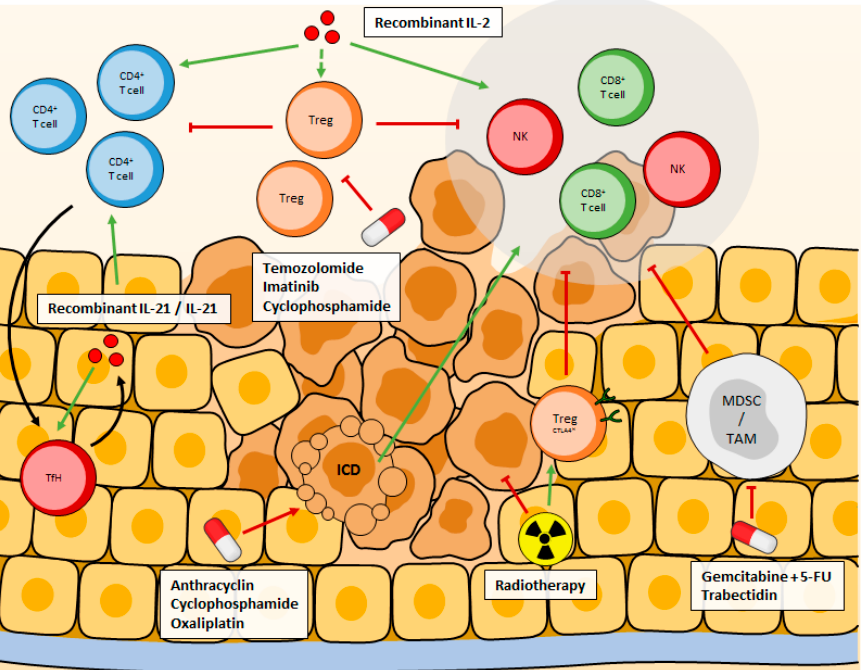
Figure 2. Recombinant IL-2 is designed to preferentially bind to IL2R α or IL2R βγ to avoid Tregs expansion, while stimulating CD4 + , CD8 + , and NK cells. Recombinant IL-21 also stimulates CD4 + , CD8 + , and NK cells as well as TFh cells, creating an auto-amplification loop. Some treatments inhibit Treg cells, MDSCs or TAM, to remove the immunosuppression they exert, while others indirectly promote anti-tumor immune response through immunogenic cell death. Radiotherapy is a double- edged sword, it directly kills tumor cells, but post-treatment it favors the recruitment of Tregs that highly express CTLA4, resulting in enhanced immune-suppression.